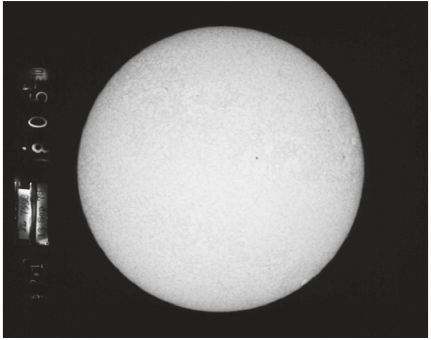
Figure 4: White character image. Figure 3: Black character